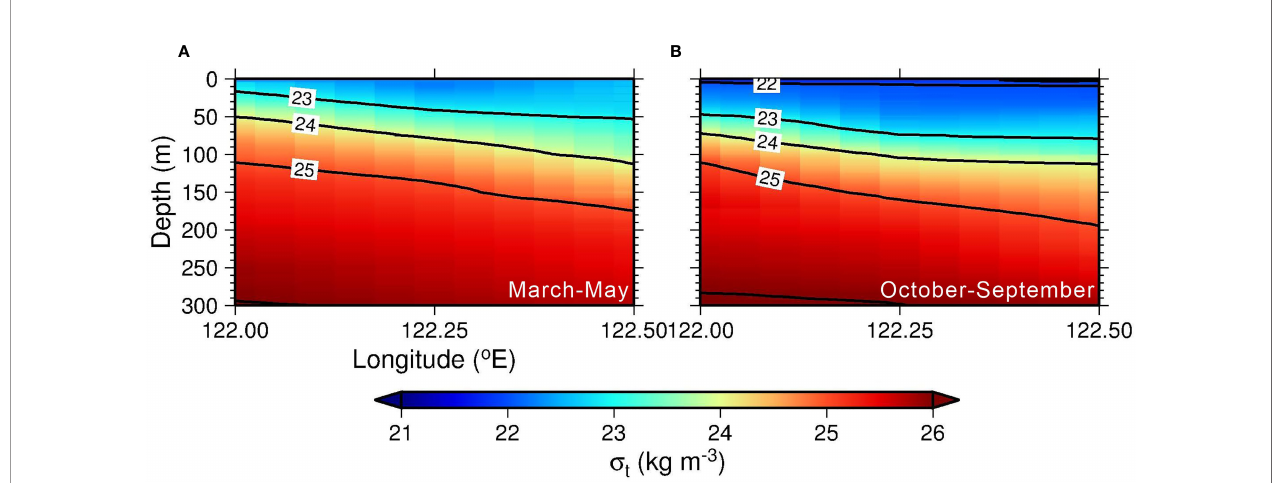
FIGURE 6 | Seasonal mean density ( s t in kg m − 3 ) at a zonal section across the Kuroshio (24.5°N), which is immediately south of the ECS shelf. (A) March – May and (B) October –